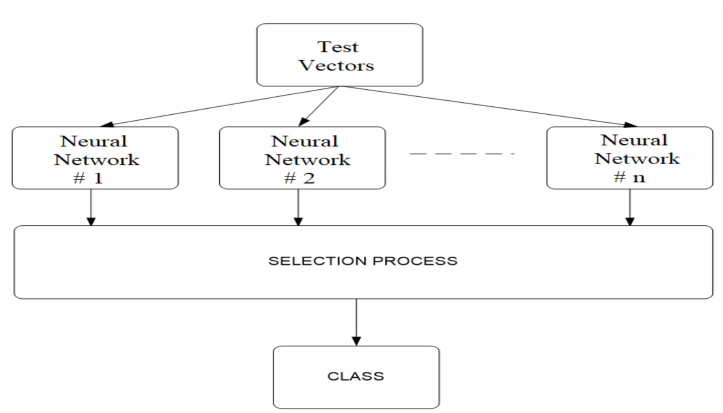
Figure 7. Diagram for UAV recognition and classification using